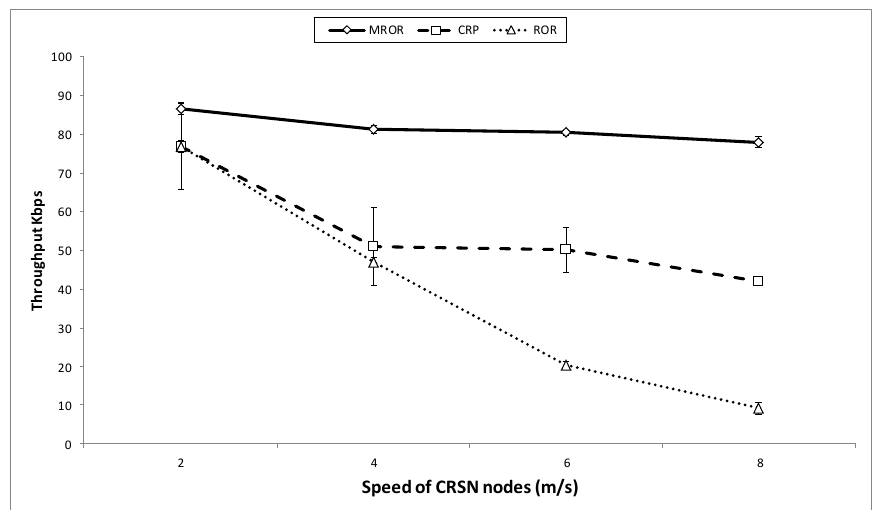
Figure 16. Throughput vs . speed of the mobile